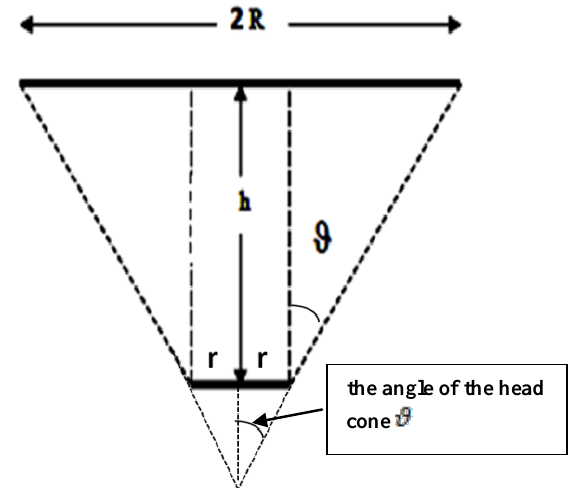
Fig.3: The schematic diagram of the plasma. Fig. 4-a, b, c and d, Fig. 5-a, b, c and d and Fig. 6-a, b, c and d show the